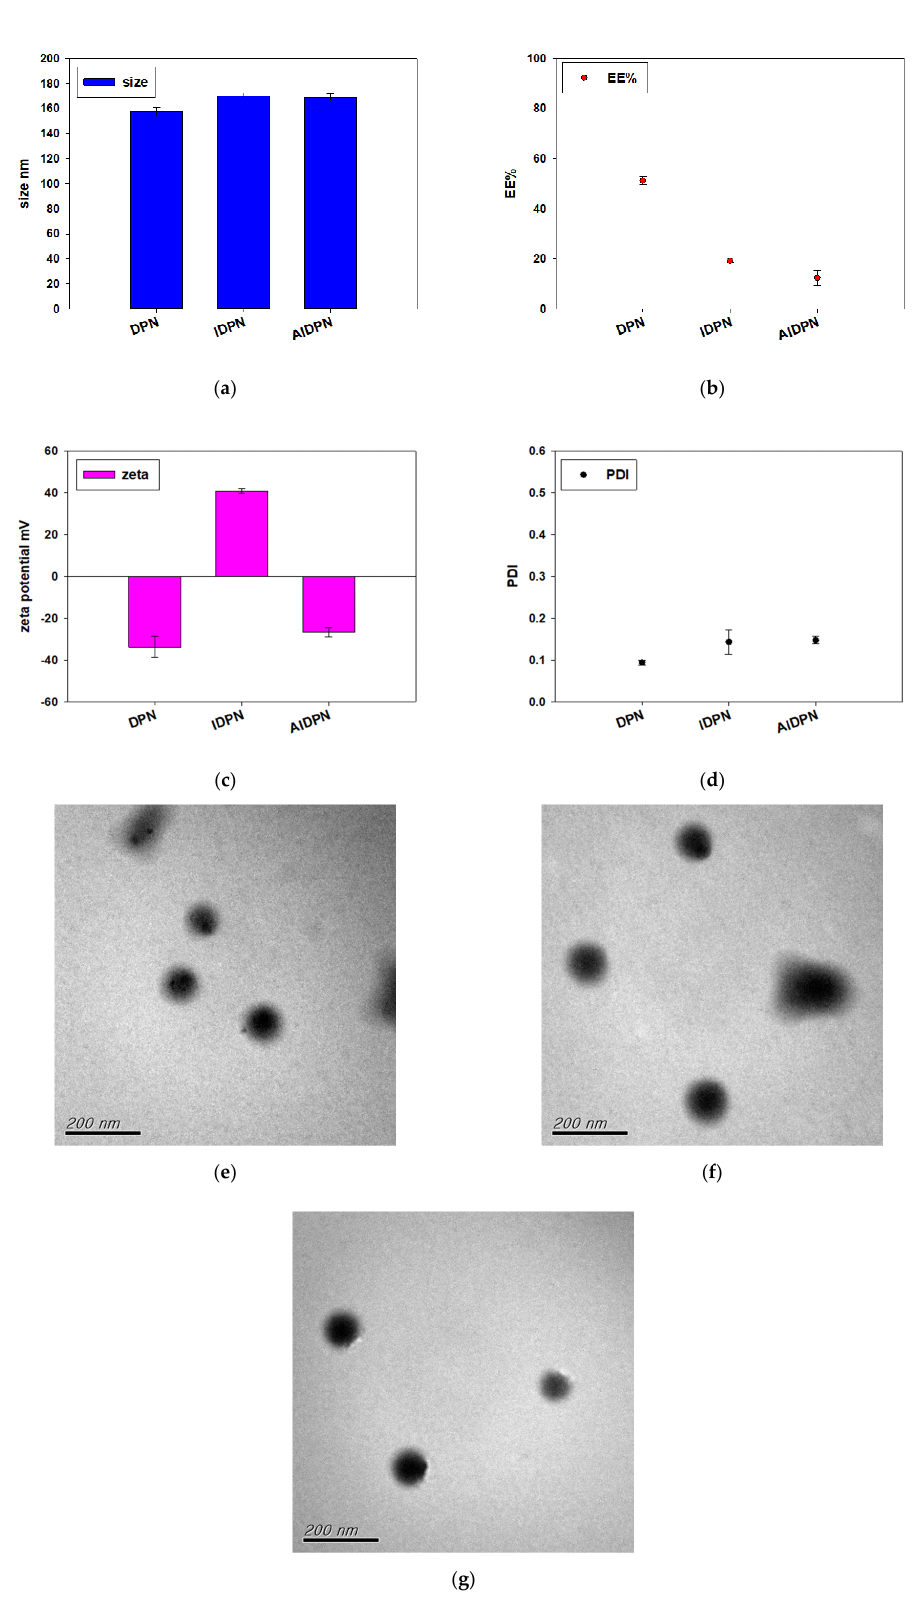
Figure 3. Characterization of DPN, IDPN, and AIDPN. ( a ) diameter, ( b ) EE%, ( c ) zeta potential, and ( d ) PDI. (n = 3; mean ± standard deviation). Morphology of ( e ) DPN, ( f ) IDPN, and ( g ) AIDPN on TEM image.